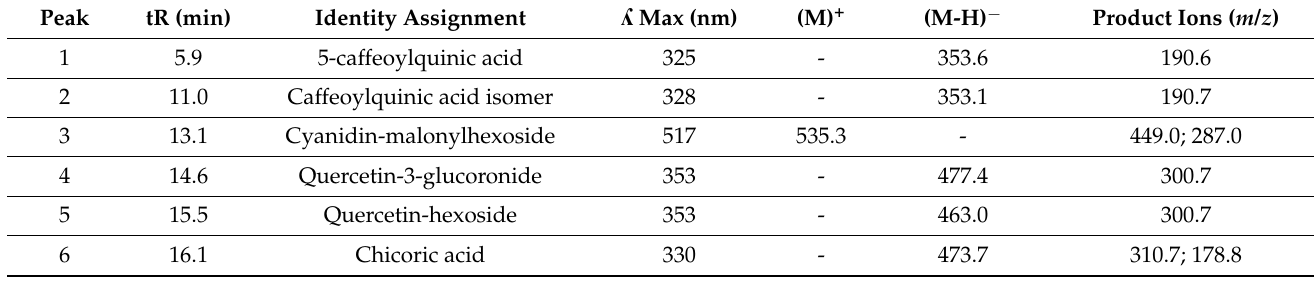
Table 1. Identification of phenolic compounds from red lettuce leaves by HPLC-DAD-ESI-MS/MS at 60 days after sowing.